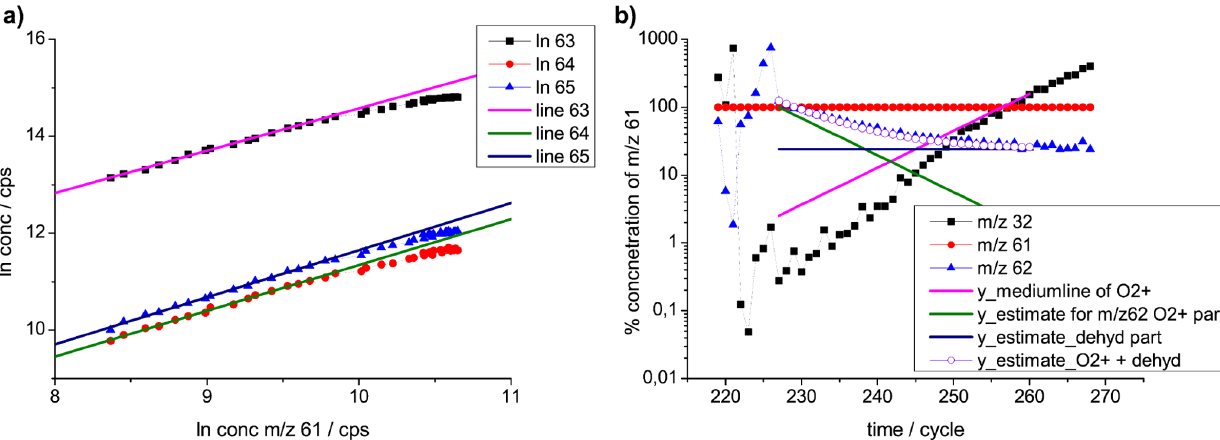
Figure 2. Details for DMS in PIDK. a) DMS isotopologue ratios. Demonstration of the deviations from the expected isotopologue ratios. The MH + of DMS is 63, and the isotopolouges are m/z 64 and 65. In principle, parallel lines of the isotopologues would be expected, however, this is not perfectly the case. Plot of log concentration (conc) m/z 61 versus log concentration of m/z 63, log m/z 64 and log m/z 65, demonstrating the correct isotopologue ratio and deviation therefrom. Deviations are interpreted as results from dehydrogenation reactions, e.g. m/z 63 to m/z 61. m/z 61 was chosen as x-axis as it is the result solely of dehydrogenation from m/z 63 to [MH + - H 2 ]. Other signals at various m/z are the results of a combination of isotopologues of m/z 63 and dehydrogenation reactions. The parallel diagonal lines are intended as help to guide the eye. b) DMS signal m/z 62. Signal m/z 62 ( m ) as result of a dehydrogenation from m/z 64 and a charge transfer from O 2 to DMS. The contribution from charge transfer is estimated from the behavior of O 2 + (monitored at m/z 32 ( & ) (y_mediumline of O2 + ) as the inverse therefrom (y_estimate for m/z 62 O 2 + part) (yielding M + ). The contribution from the dehydrogenation reaction (yielding [MH + –H 2 ] ) to signal m/z 62 is estimated from the signal of m/z 62 under non-depleted conditions at the end of the monitored time (y_estimate_dehyd part). The two effects together superimpose excellently ( # ) as y_estimate_O2 ++ dehyd, compared to the measured curve of m/z 62 ( m ). All concentrations are given as % of m/z 61 (